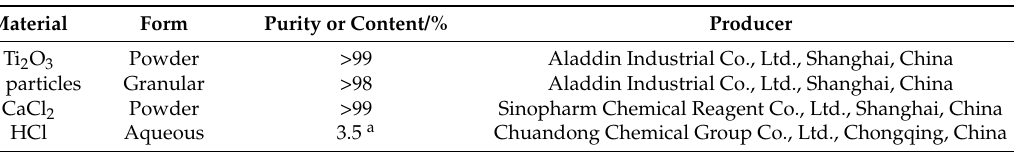
Table 1. Materials used in